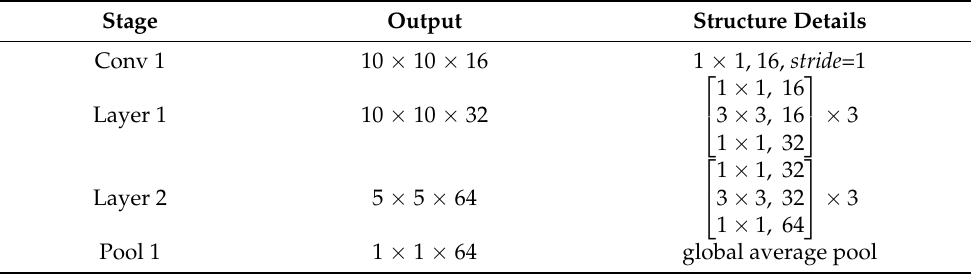
Figure 9. Schematic diagram of the ResBlock. Table 3. Details of the CNN